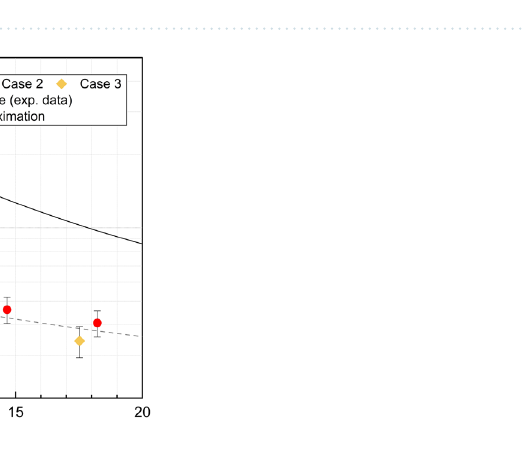
Table 3. The regression output shows that all three parameters p , q , and r are statistically significant. Finally, the solid curve included in Fig. 7 corresponds to the prediction by the reduced-order displacement model, defined by Eqs. (1), (2), (3) and the closure relations presented in the “Appendix”, for an imposed flow rate corresponding to 1.05 L/min. We observe from Fig. 7 that the model is conservative and over-predicts the